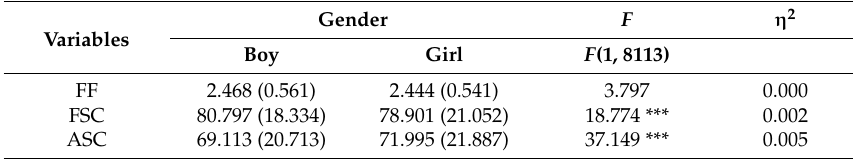
Table 3. Means, Standard Deviation (SD) and results ANOVA between gender and family functioning, family self-concept and academic